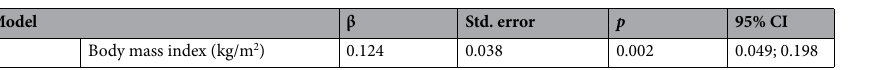
Model β Std. error